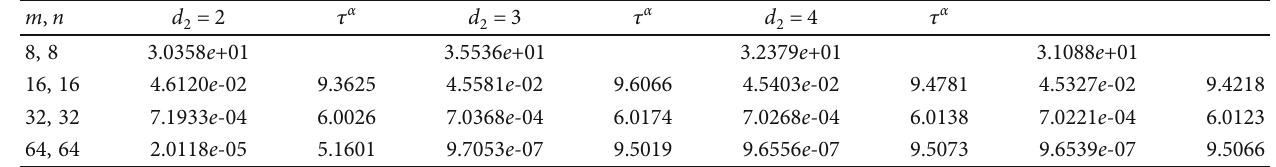
= 7 at t = 1 for equidistant nodes. 1